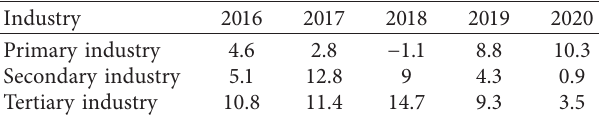
Table 3: Summary of annual growth rate data of three major industries (unit: %).